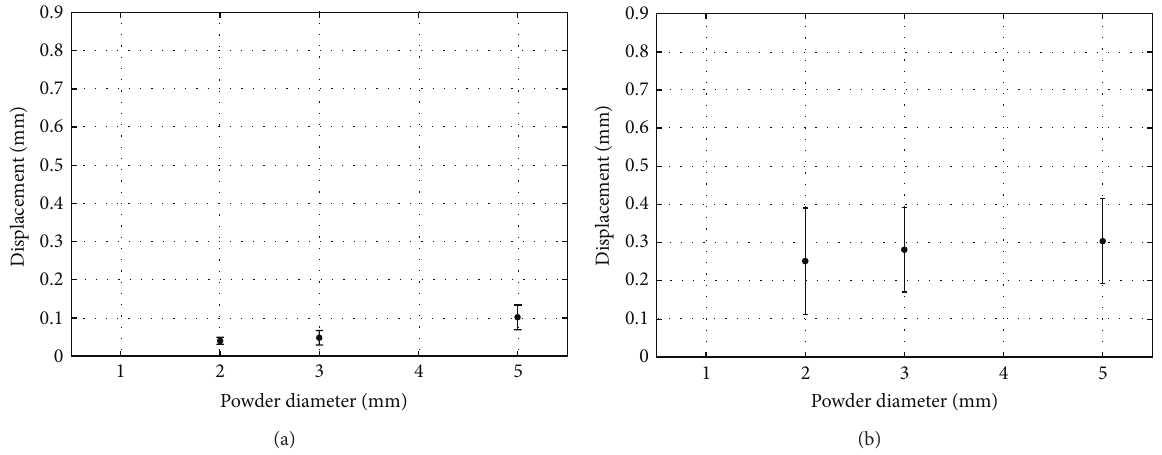
Figure 15: Graph shows the relationship between the grain diameter for the jamming transition and the deformation of the holding device to (a) 40-N downward load, (b) 40-N horizontal load when the holding device is affixed to a flat